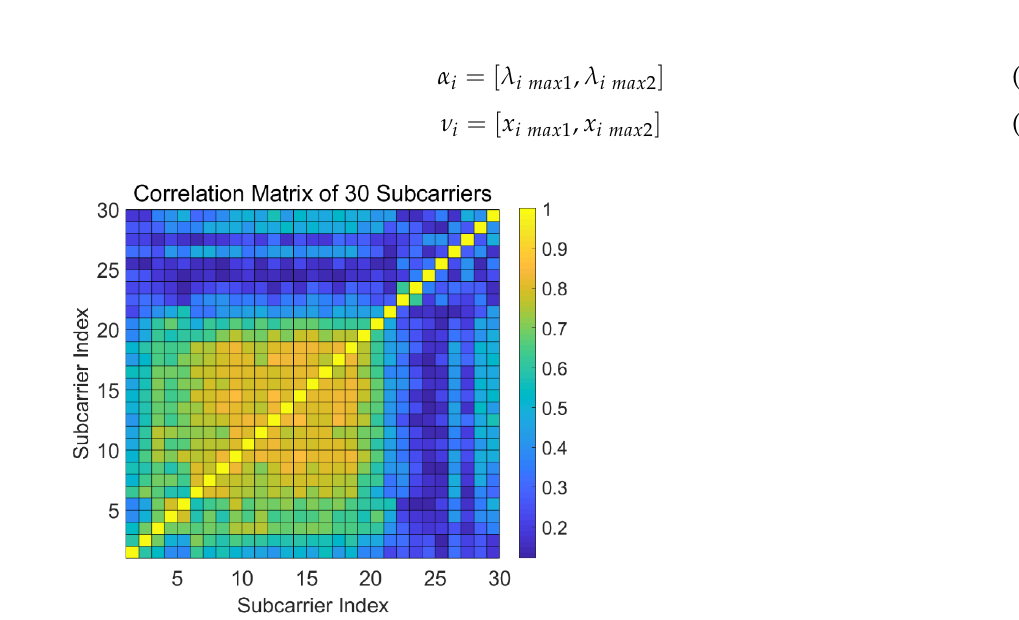
Figure 4. Correlation matrix of 30 subcarriers of a randomly selected link pair during a fixed time sliding window. The color bar represents the entity of each correlation coefficient.